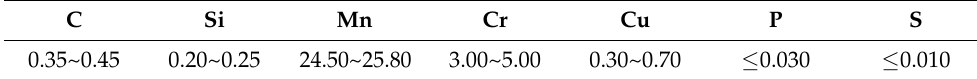
Table 2. Chemical composition of the base material (wt. %).